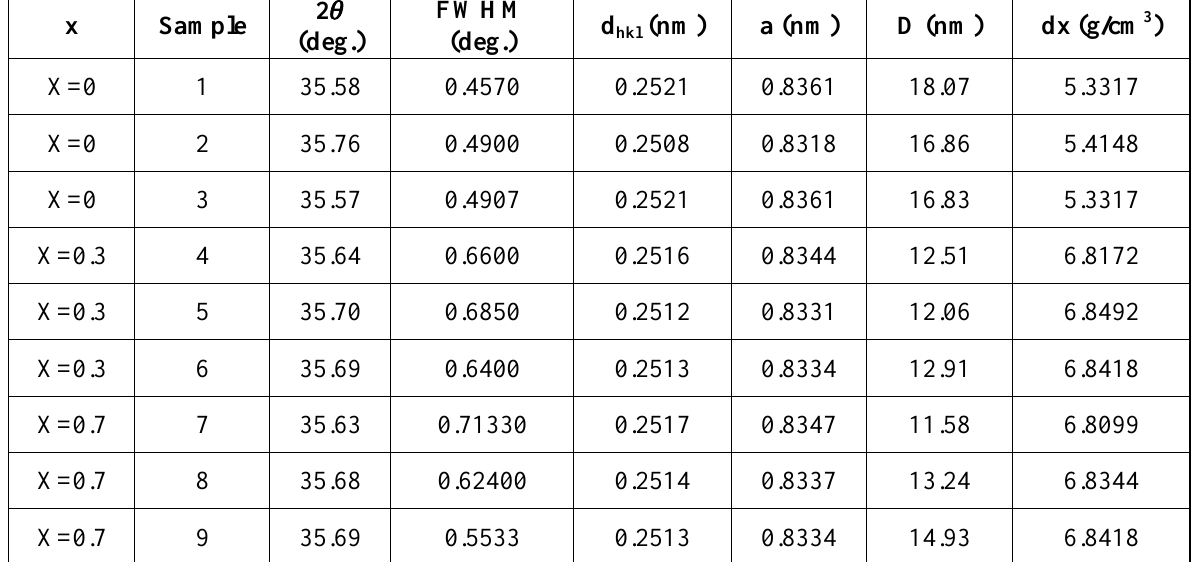
Cu Fe O ferrite samples. Experimental 1-x x 2 4